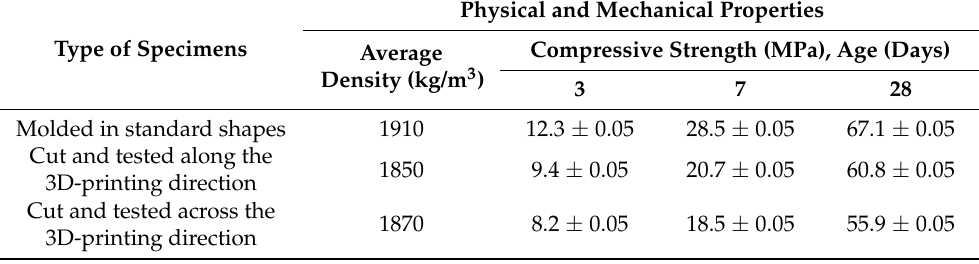
Table 13. Physical and mechanical properties of specimens depending on the method of casting and